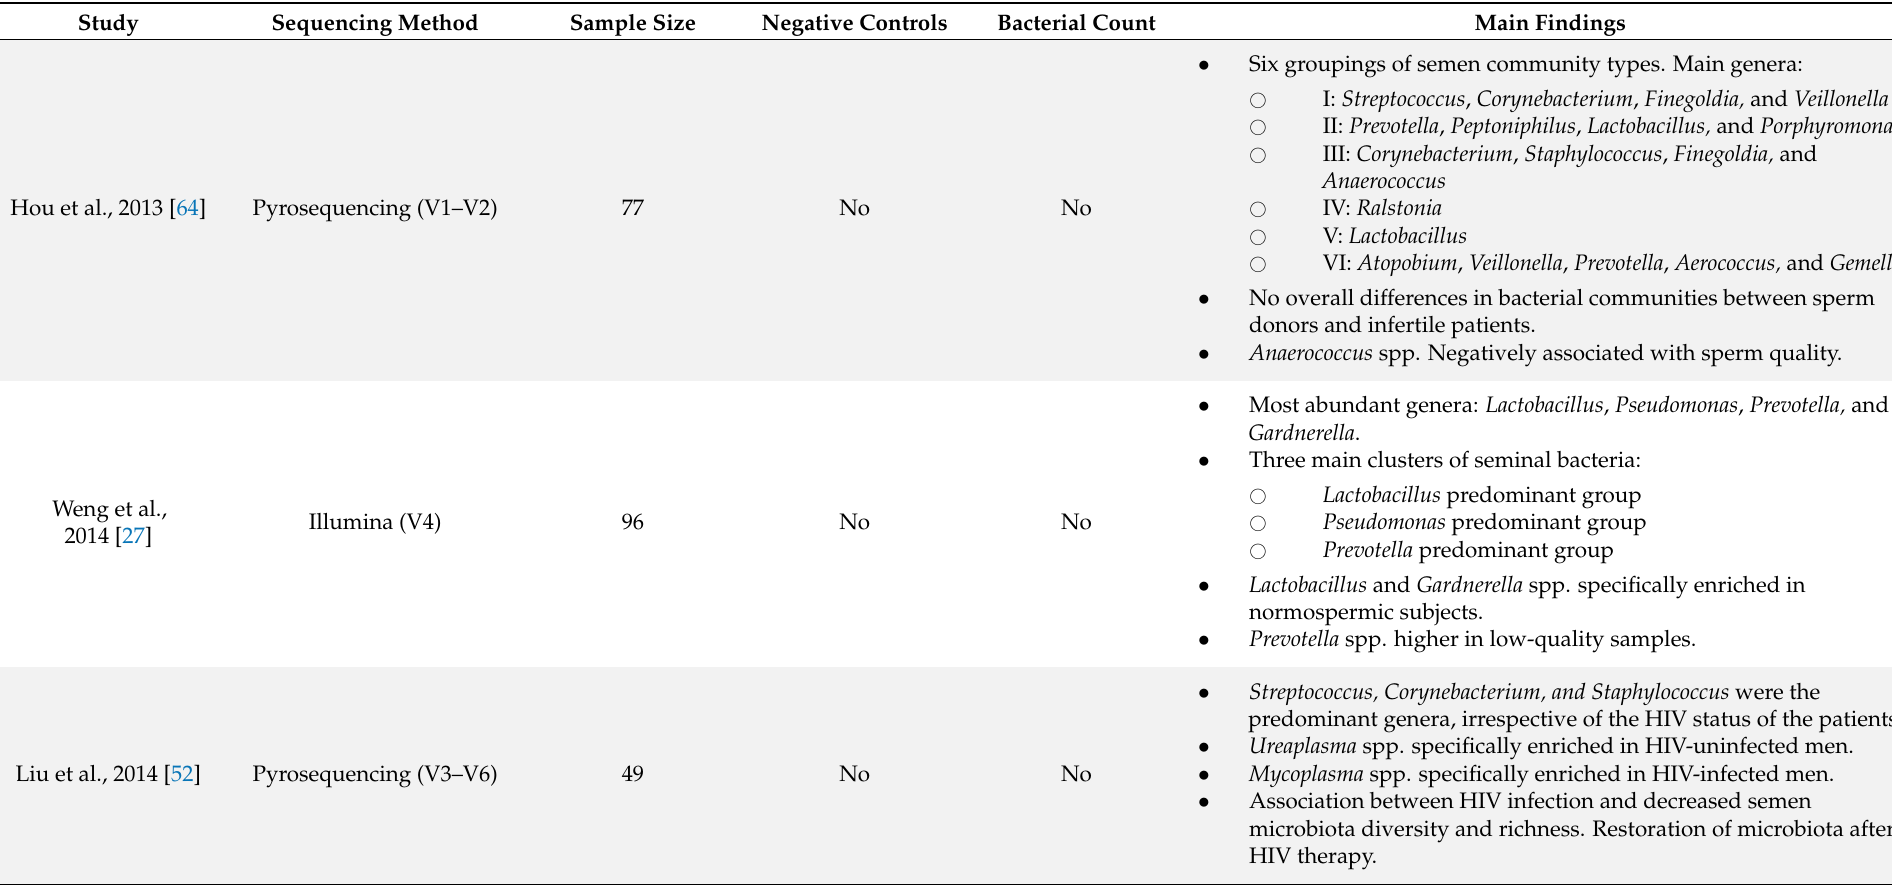
Table 3. Characterisation of seminal microbiota using